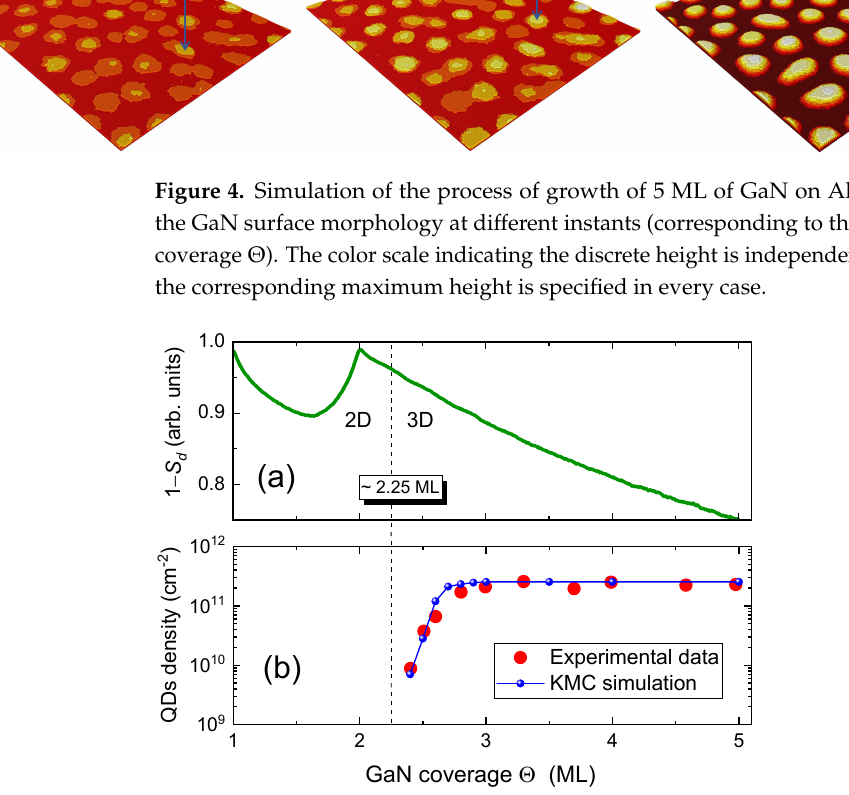
Figure 5. ( a ) Evolution of the step density 1 − S d as a function of Θ . The vertical line at ≈ 2.25 ML indicates the critical thickness at which the 2D-3D SK transition occurs. ( b ) QD density as a function of Θ . The results obtained from the KMC simulations are compared with the experimental data of Ref.